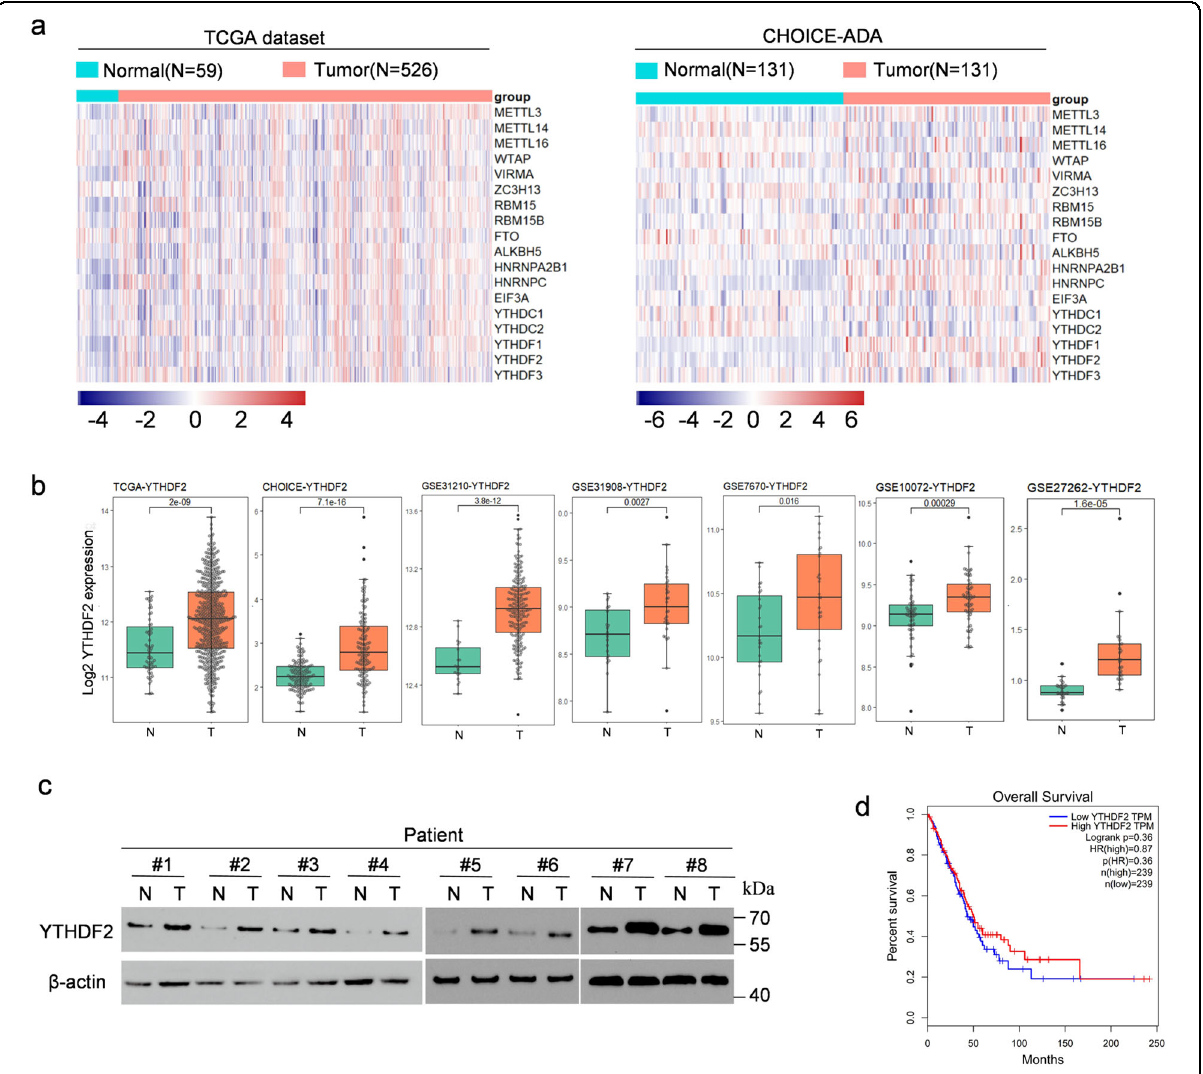
Fig. 1 YTHDF2 was highly expressed in LUAD. a Heat map pro fi ling the expression of m6A WERs in TCGA (left) and CHOICE (right) databases of LUAD. b Relative RNA levels of YTHDF2 in LUAD tissue and normal lung tissue in TCGA, CHOICE, and GEO datasets. c Immunoblotting assay of YTHDF2 expression in eight paired LUAD primary tumor samples. β -actin was used as a loading control. d ) Kaplan – Meier analysis of LUAD cancer in TCGA for the correlations between YTHDF2 expression and overall